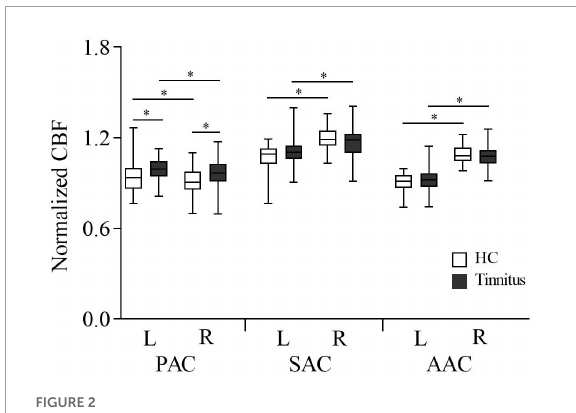
FIGURE2 Normalized CBF according to ROI analysis of the auditory cortex in tinnitus patients and HCs. AAC, auditory associative cortex; SAC, secondary auditory cortex; PAC, primary auditory cortex; CBF, cerebral blood flow; HC, healthy control; ROI, region of interest; L, left; R, right. ∗ Statistical significance.